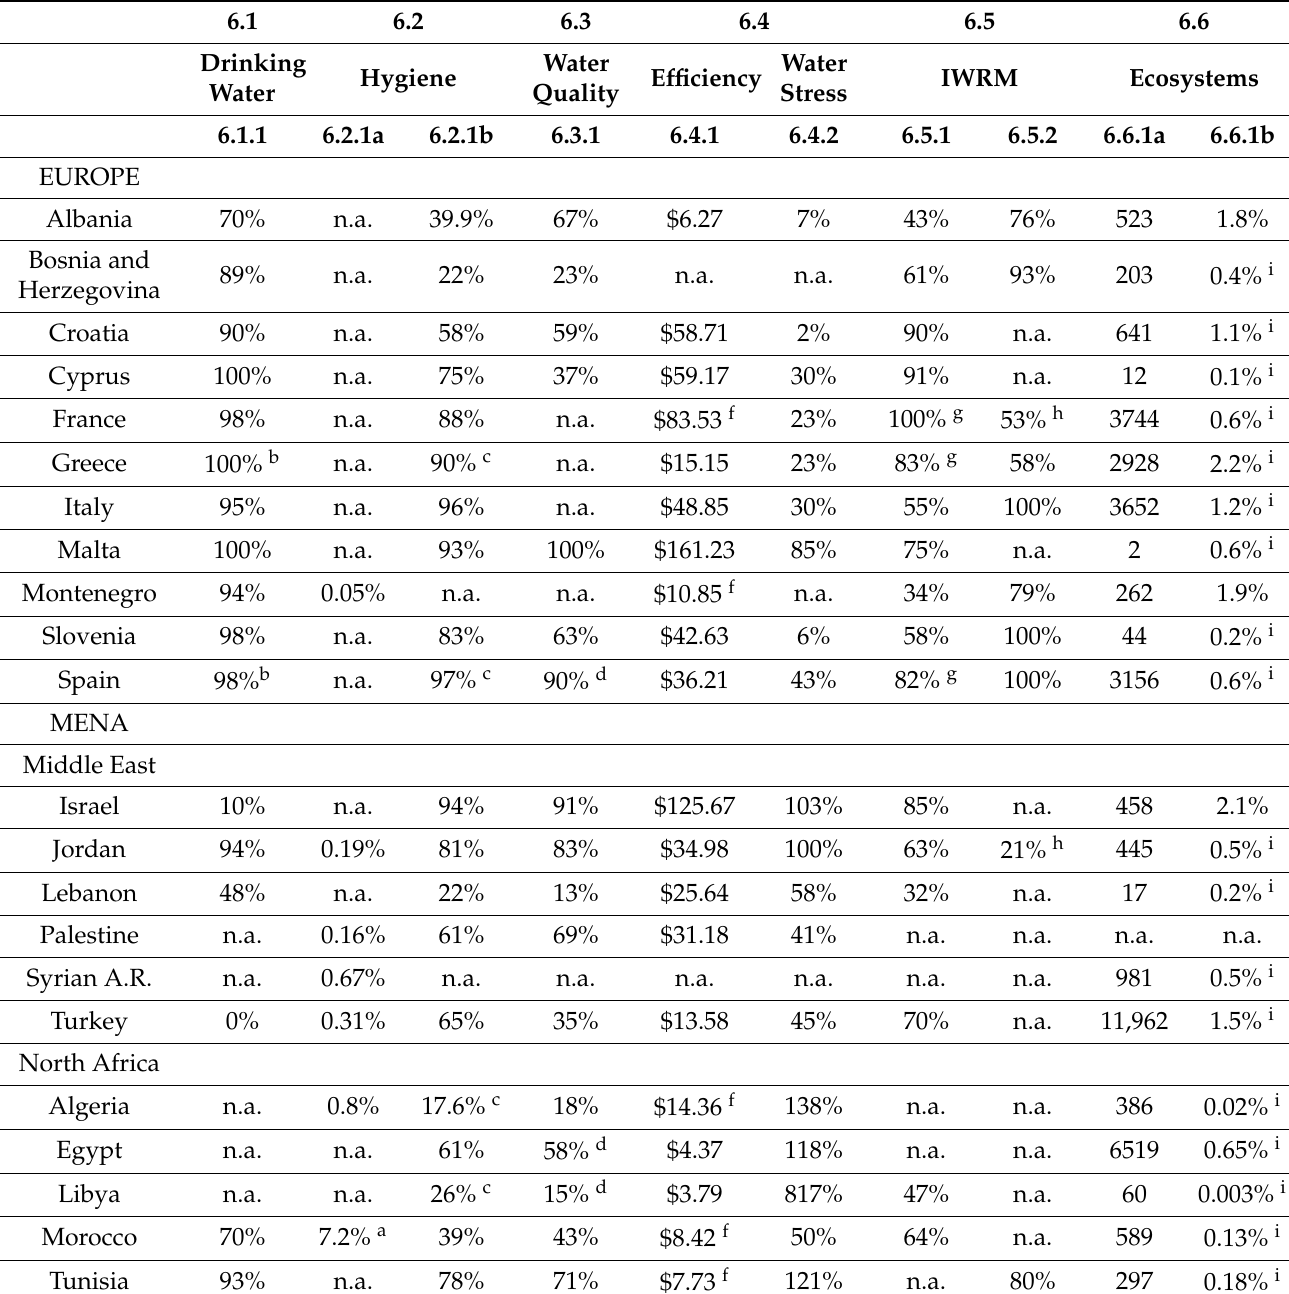
Table 2. Mediterranean Countries’ performance: main indicators